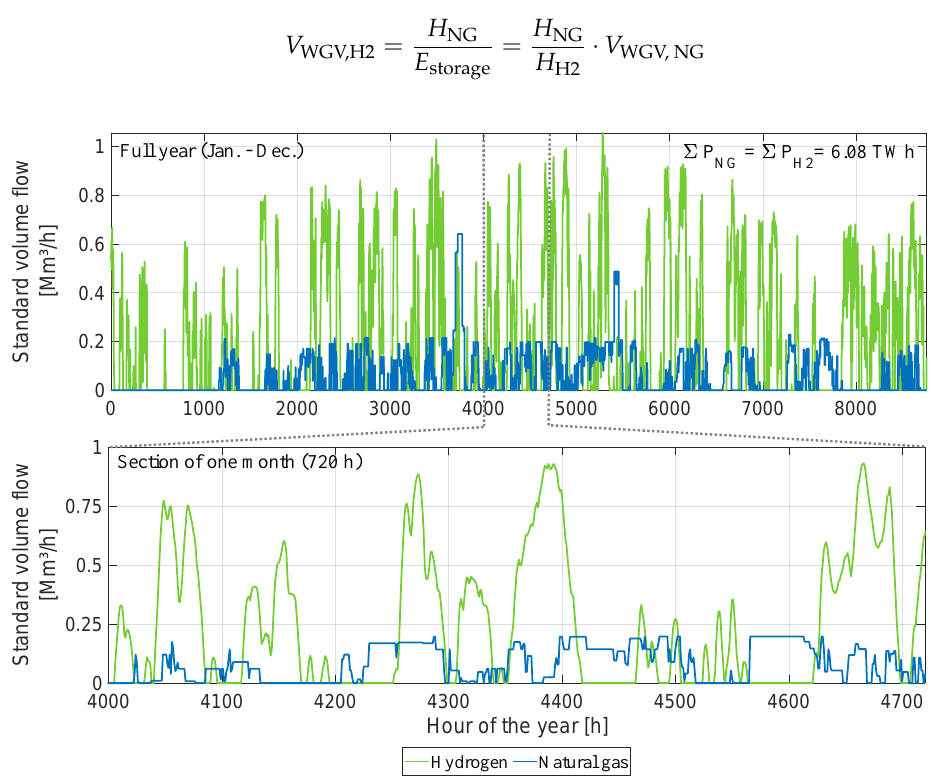
Figure 7. Comparison of the standard volume flows of injection between natural gas (blue) (based on data from [50]) and hydrogen (green) storage with balanced annual energy quantities, over the course of a calendar year (top) and for the period of one month in summer (bottom). Table 2. Comparison of the required storage conditions for hydrogen and natural gas storage parameters. Basis of the comparison is the amount of annually stored energy (hydrogen) calculated above. Energy parameters are based on the respective gross calorific